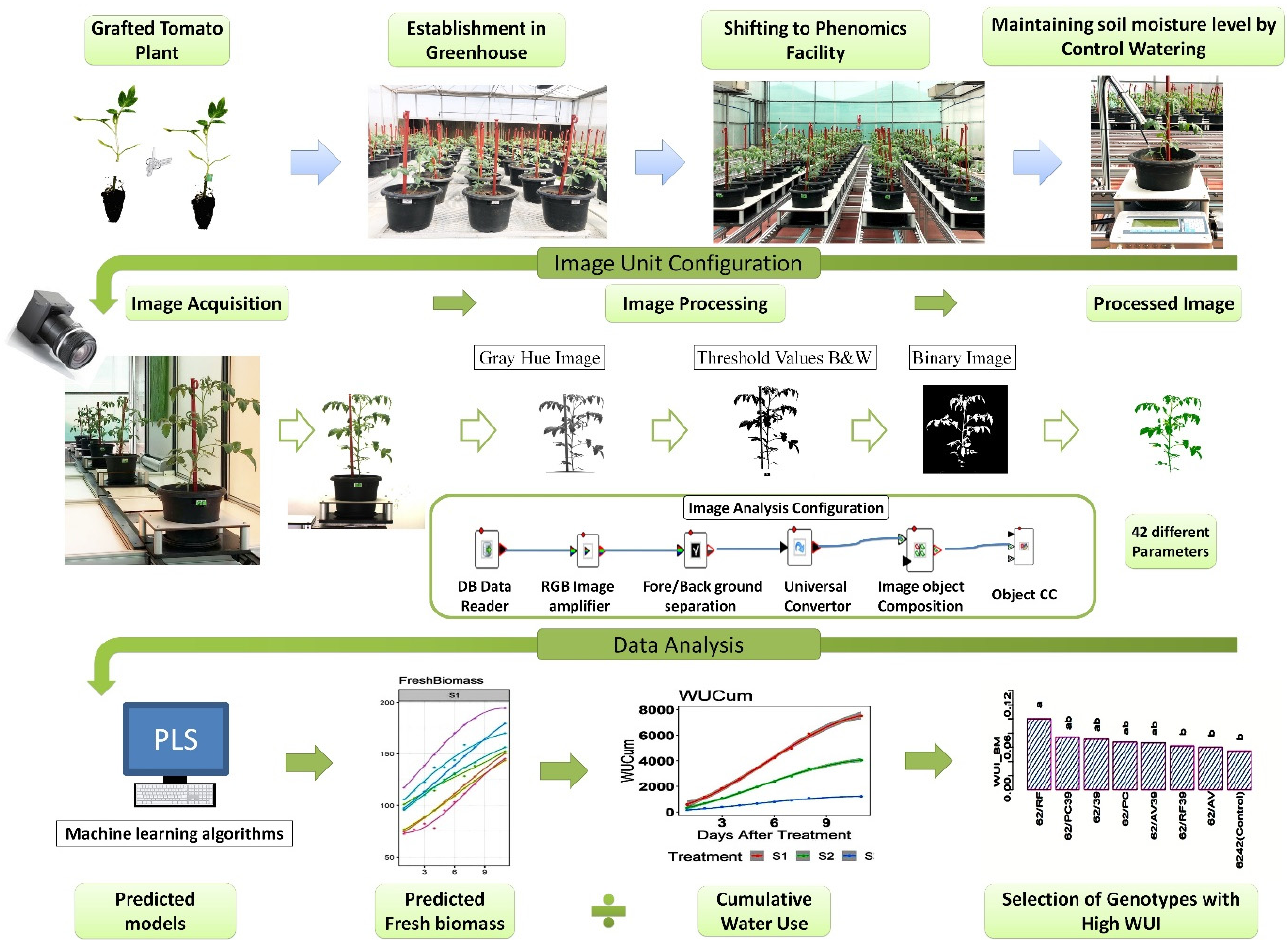
Figure 6. Protocol for phenotyping of grafted tomato plants under different soil moisture regimes in phonemics facility.